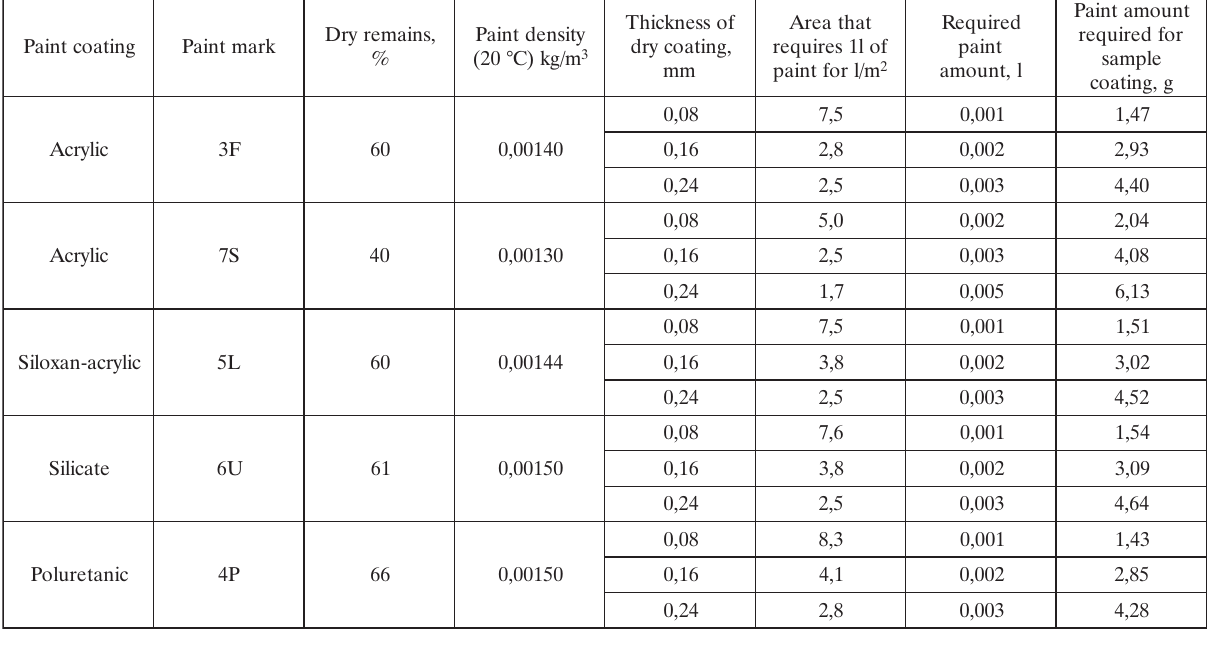
Table 3. Physical parameters of the envelope layers ehtfoepyT